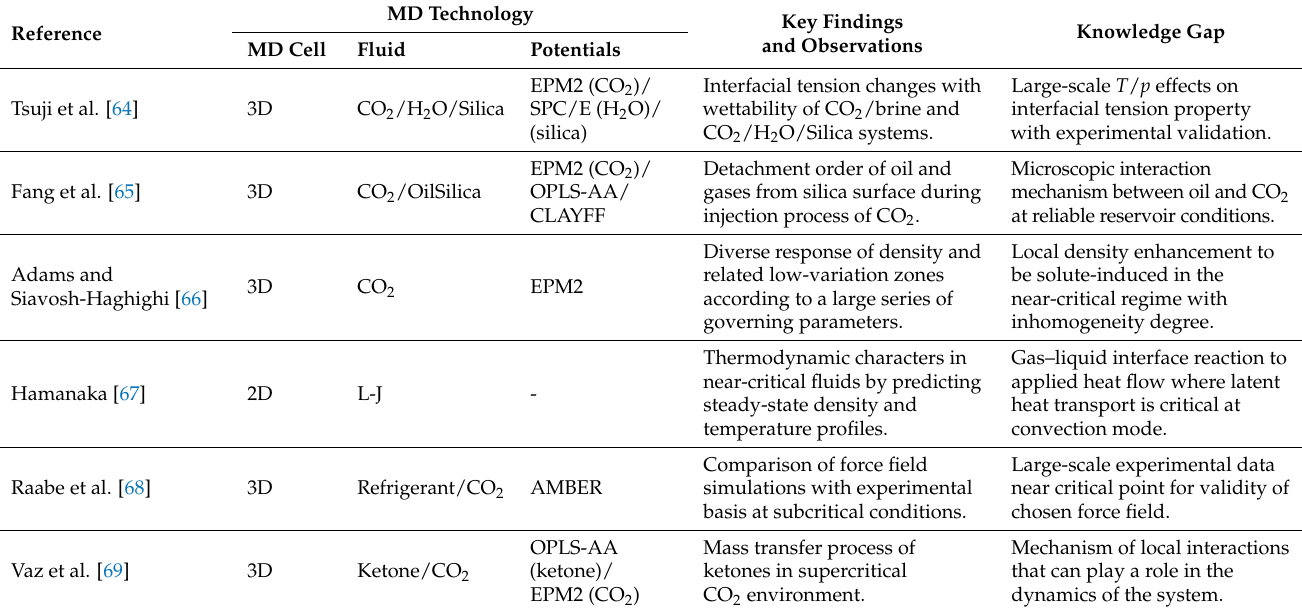
Table 1. Related case works that used diverse potentials for MD of CO 2 molecules and L-J fluids